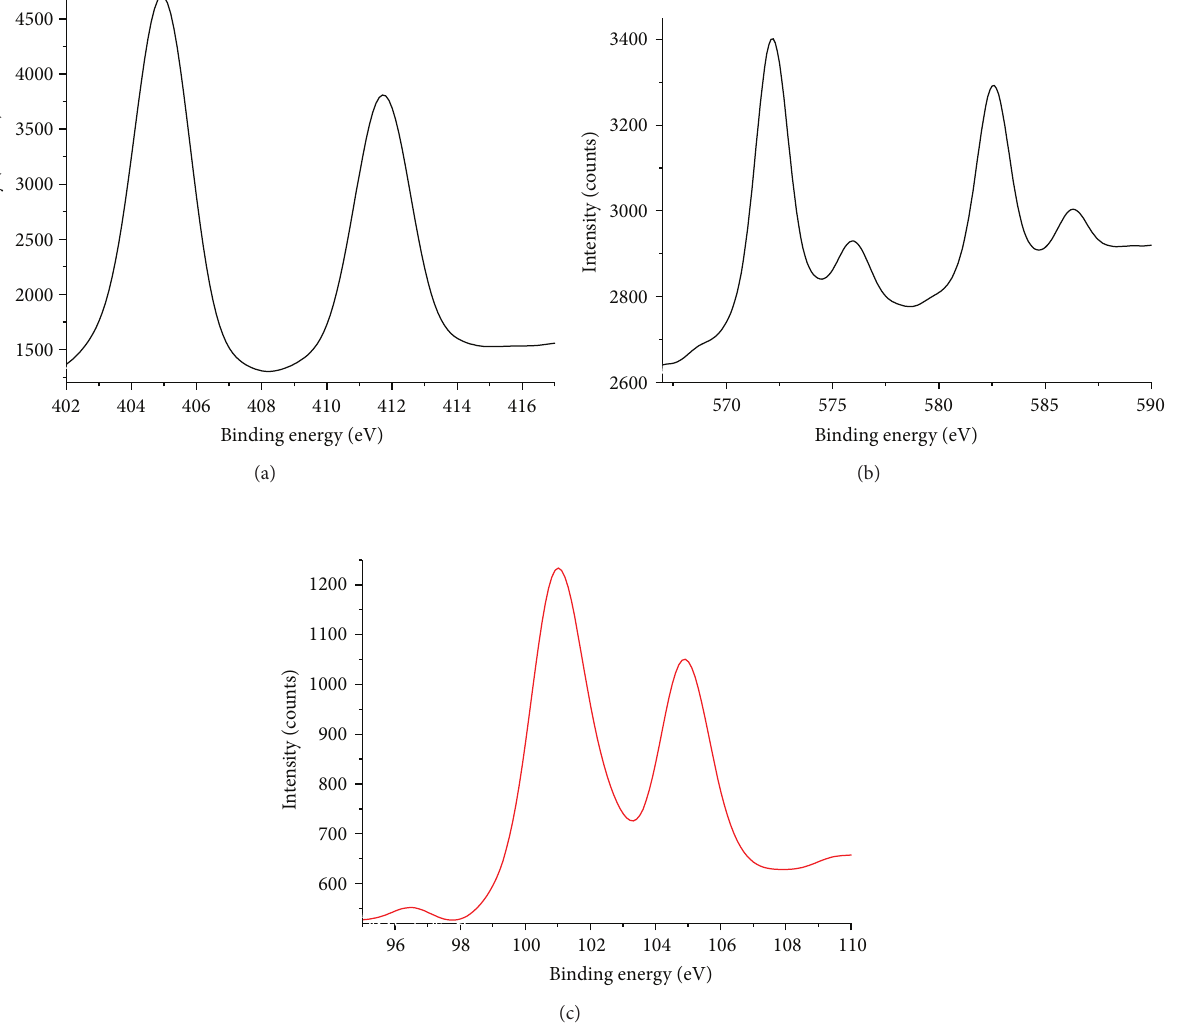
Figure 6: XPS of NAC-capped Cd 𝑥 Hg 1−𝑥 Te NCs: (a) Cd (3d), (b) Te (3d), and (c) Hg